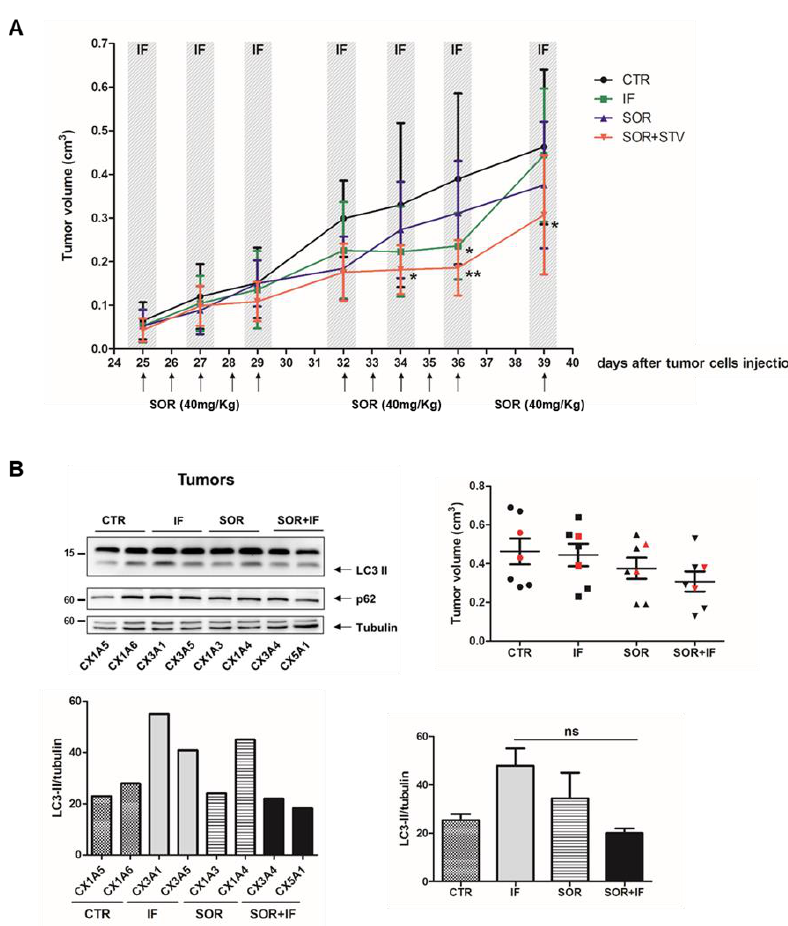
Figure 6. In vivo effect of intermittent fasting cycles combined to sorafenib on melanoma growth and autophagy. ( A ) SK Mel 28 cells were subcutaneously inoculated on NOD/SCID mice (2.5 × 10 6 cells/mouse) and tumor size was measured every two days and tumor volume was calculated (see material and methods; n = 6; * p < 0.005; ** p < 0.001 compared to control animals). ( B ) Tumor size distribution at day 39 of data shown in A and reported (right panel) and LC3 conversion and p62 degradation (autophagic markers) were analyzed by western blotting in tumor samples from two animals of each experimental group (red marked on graph). Tubulin was used as loading control. Densitometric analysis of LC3II/tubulin in each select tumor (lower left graph) and the median of each group (lower right graph). Groups: CTR (ad libitum diet + PBS/6%DMSO oral gavage); IF (24 h fasted/24 h ad libitum diet + PBS/6%DMSO oral gavage); SOR (ad libitum diet + SOR (40 mg/Kg in PBS/6%DMSO) oral gavage); SOR+STV SOR (24 h fasted/24 h ad libitum diet + SOR (40 mg/Kg in PBS/6%DMSO) oral gavage). ns (not significant). One-way ANOVA, Bonferroni post-test. The following development of subcutaneous tumors was monitored in the subsequent 25 days post injection. Then, mice were randomly divided into 4 groups (6 animals each) and submitted to cycles of intermittent fasting alone (IF, DMSO) and in combination to sorafenib (SOR, 40 mg/kg) treatment (IF + SOR) or with free access to food and water (CTR, DMSO) and treatment with sorafenib (SOR), and tumor volume was recorded every two days, together with mouse weight (Supplementary Figure S6A), for an additional 14 days. Data reported in Figure 6A show a consistent and significant inhibition of tumor growth in mice subjected to combined sorafenib and intermittent fasting, compared to control, corroborating in vitro data. Next, mice were euthanized, and final tumor volume, together with tumor volume/body weight ratio (Supplementary Figure S6D), was certified confirming that intermittent fasting enhanced reduced median tumor growth (Figure 6B, right panel). The induction of autophagy was then evaluated in two tumor samples of each group by measuring the conversion of LC3 and degradation of p62, by western blotting analysis. Data reported in Figure